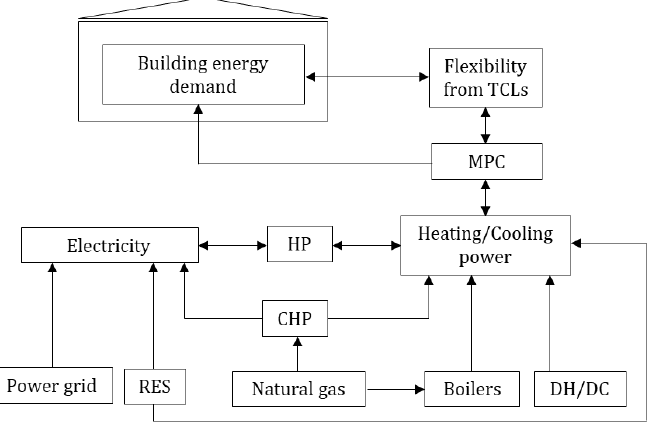
Figure 1. Scheme of an MPC controller used to exploit MESs in buildings.